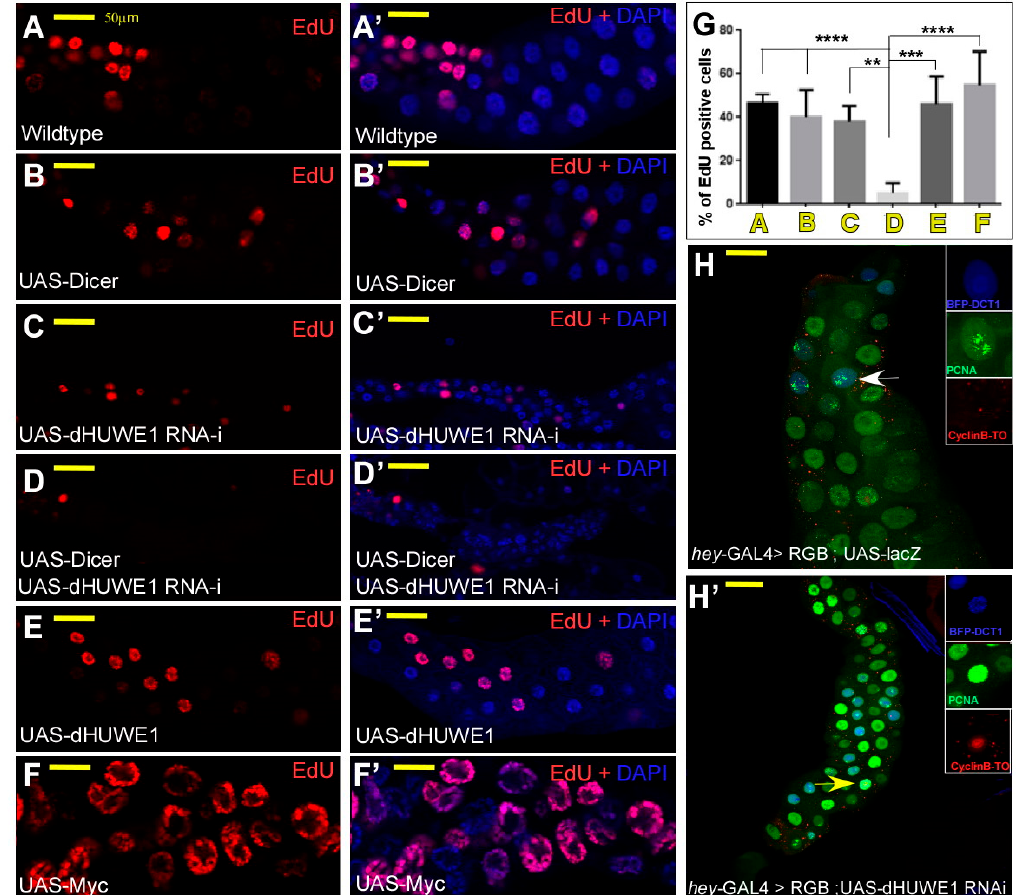
Figure 3. RNAi-mediated depletion of dHUWE1 results in failure to enter S-phase and aberrant cell cycle phasing. ( A–F’ ) Representative indirect immunofluorescence confocal microscopy images of wild-type or the indicated transgenic lines under the control of ptc -Gal4 labeled with EdU, indicating active DNA synthesis. DAPI (blue) marks DNA and the scale bar is 50 µ m. ( G ) Quantification of A – F’ ** p < 0.01; *** p < 0.001; **** p < 0.0001). ( H,H’ ) Cell-cycle phasing of control ( H ), and dHUWE1-RNAi ( H’ ) targeted salivary gland cells using the in vivo transgenic RGB tracer (see text and methods for details). Arrows indicate cells shown in the magnification.